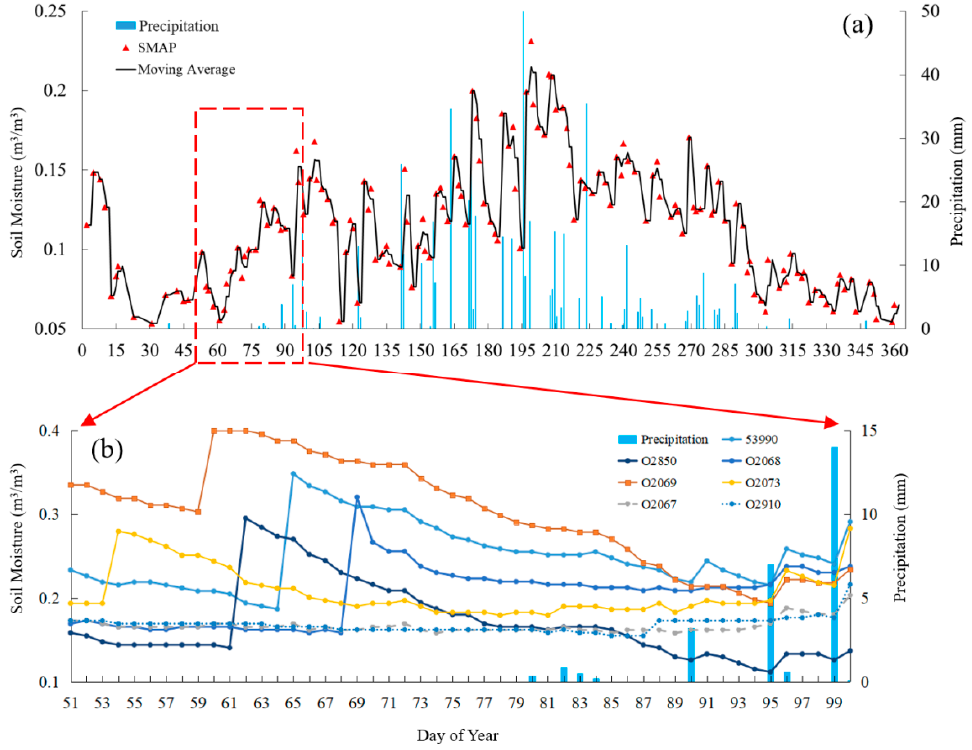
Figure 1. (a) Time series SMAP soil moisture and precipitation at one SMAP pixel. (b) In situ soil Figure 1. ( a ) Time series SMAP soil moisture and precipitation at one SMAP pixel. ( b ) In situ soil moisture at seven sites in the SMAP pixel. moisture at seven sites in the SMAP